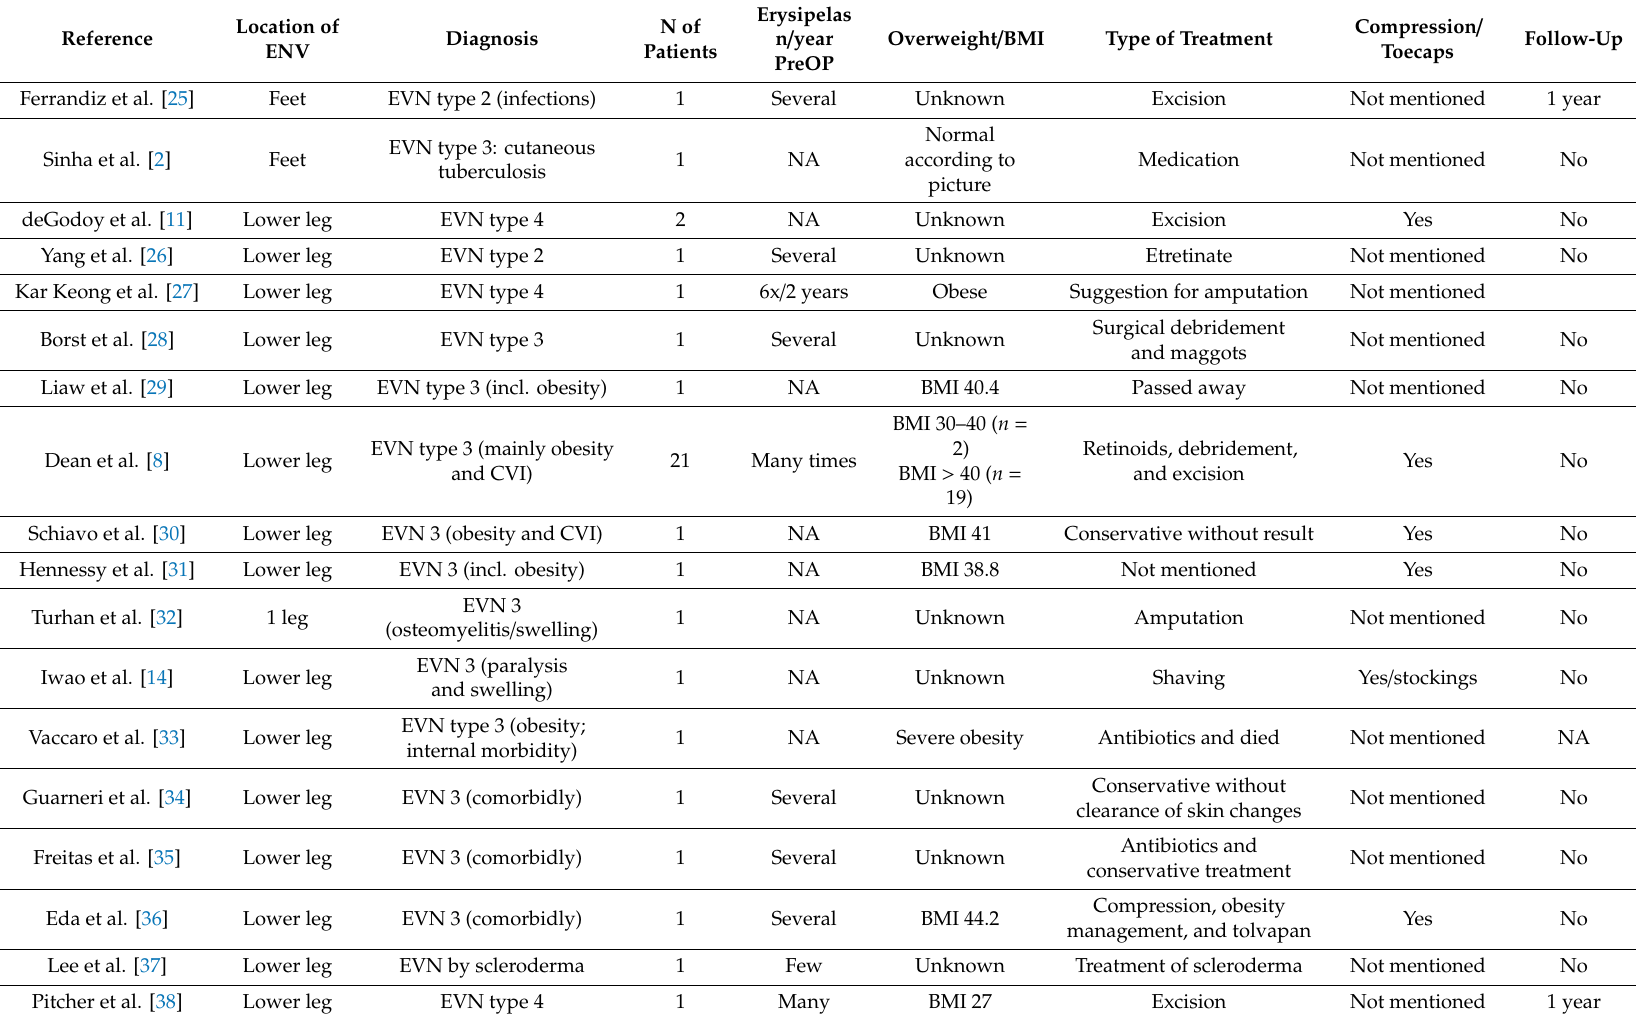
Table 3. Literature on ENV of the